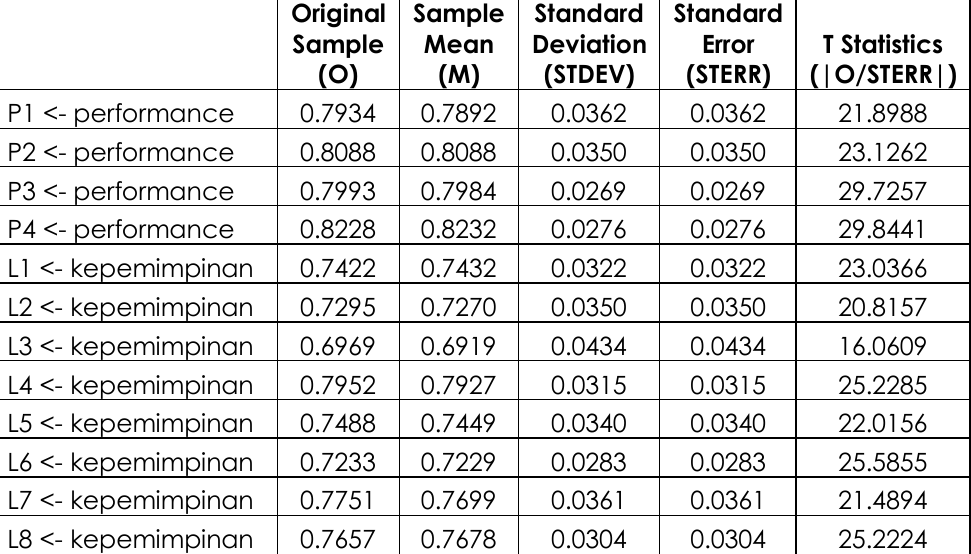
Tabel 3. Outer Loading (Mean, Stdev,